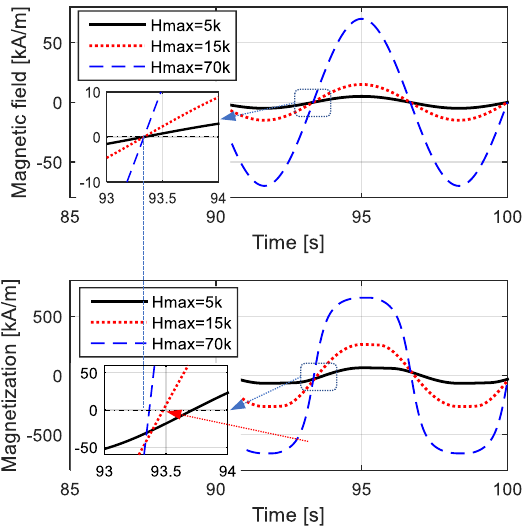
Figure 3. Time − domain curves of H and M with different amplitudes and different lagging phases.